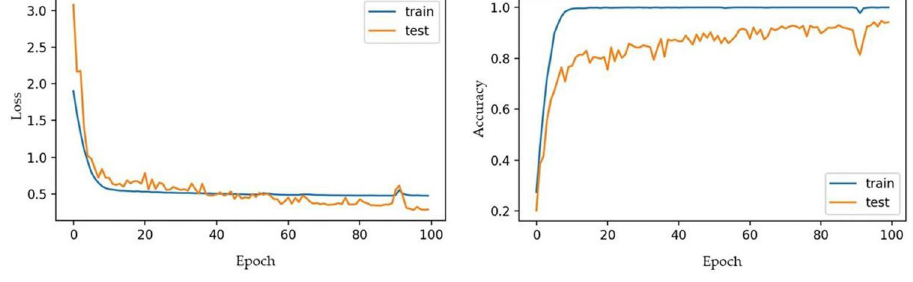
Fig. 8 The classification result of MobileNet-V2